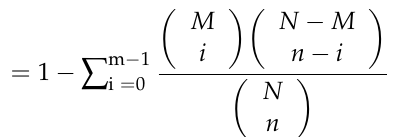
Figure 8. Differential genes and metabolites of B80124 and B80461 involved in four signaling path- ways.